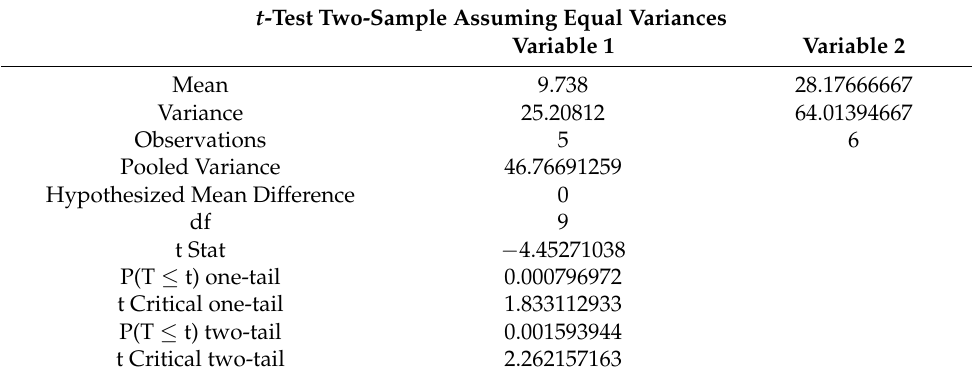
Table 6. State comparison t -Test results. t -Test Two-Sample Assuming Equal